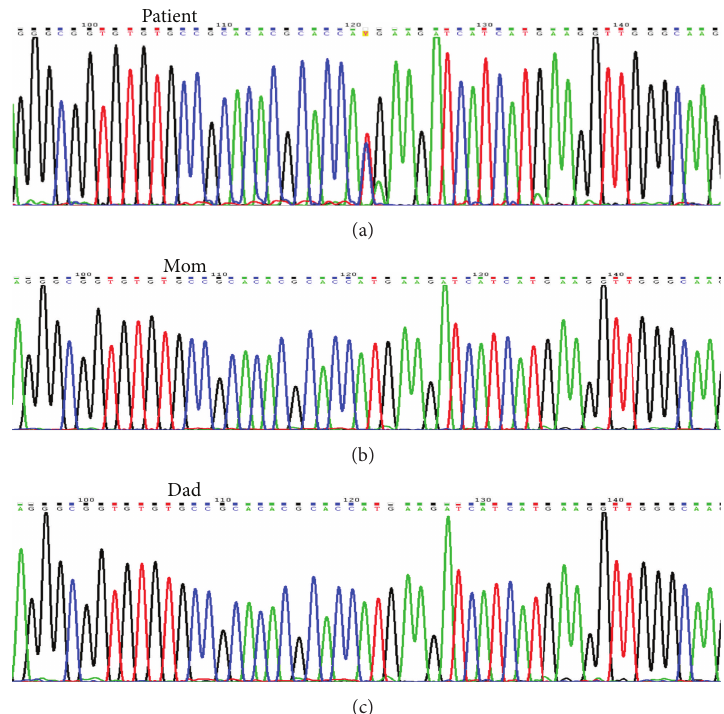
Figure 2: Partial nucleotide sequence of the EFNB1 gene in DNA from patient (a), proband’s mother (b), and proband’s father (c). (a) A heterozygous T to C transition at nucleotide position c.473 in exon 3 predicting a methionine (ATG) to threonine (ACG) replacement at residue 158 (p.M158T) is shown. (b and c) Normal nucleotide (T) in both parents.